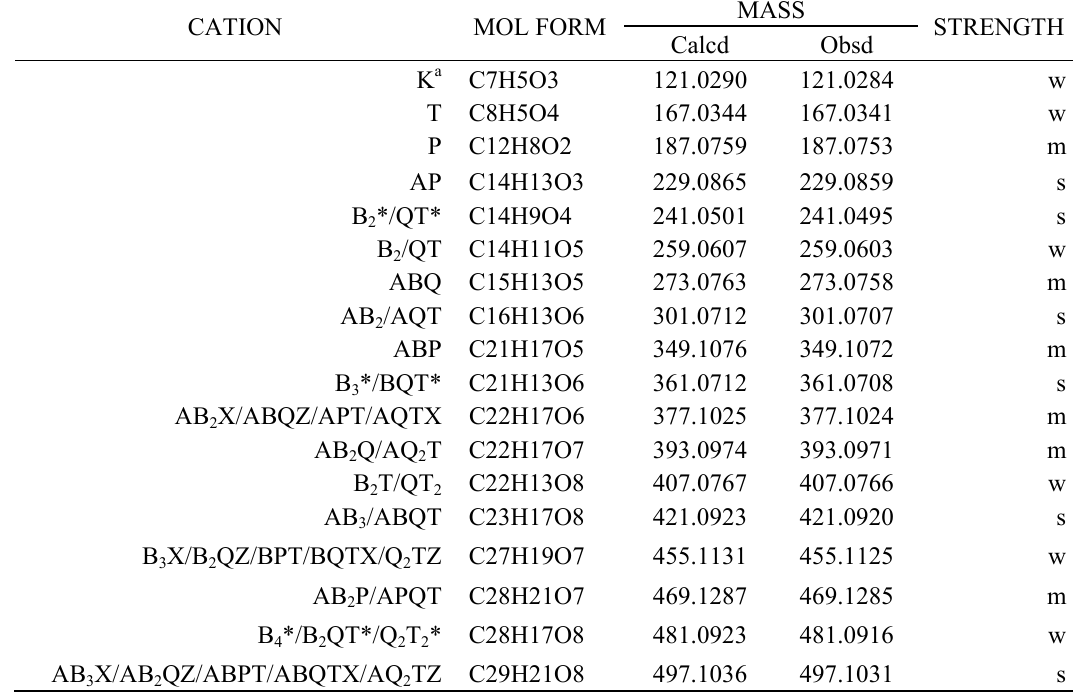
Table 5. Molecular formulas of MS peaks observed from prepolymer 1 by ESI + ; s = strong, m = medium, w = weak, * =